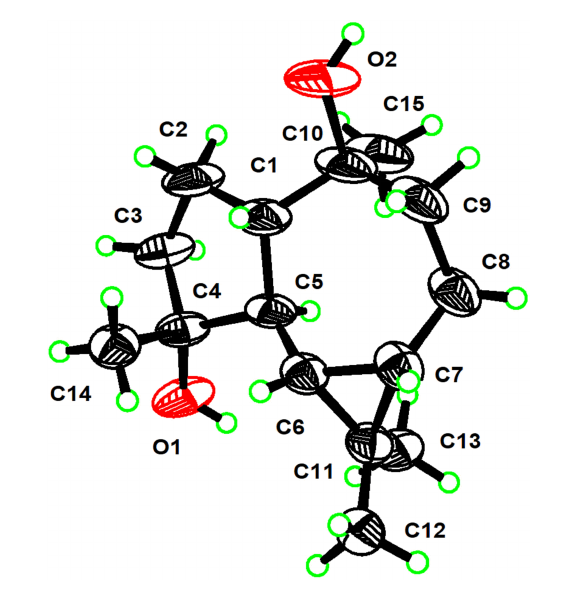
Figure 2: ORTEP drawing of 2 (displacement ellipsoids are drawn at the 50% probability